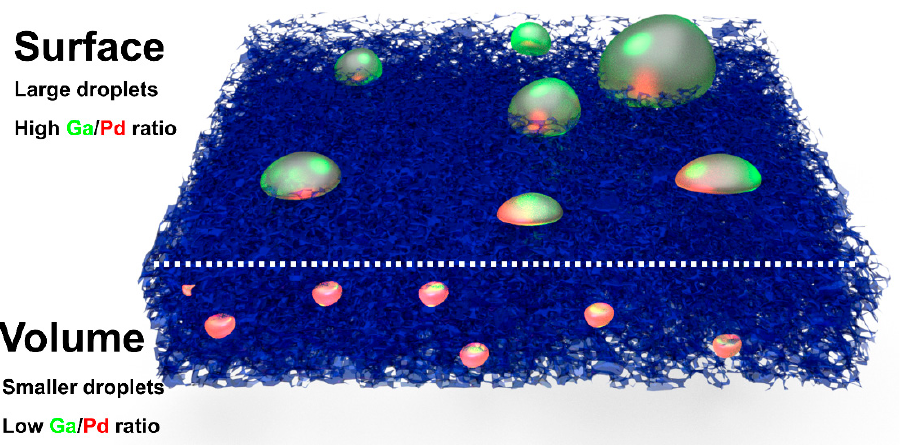
Figure 9. Adjusted structural SCALMS model featuring smaller Ga-Pd droplets with a comparably low Ga/Pd ratio inside the porous glass network (volume). The droplets on the surface are typi- cally much larger featuring a very high Ga